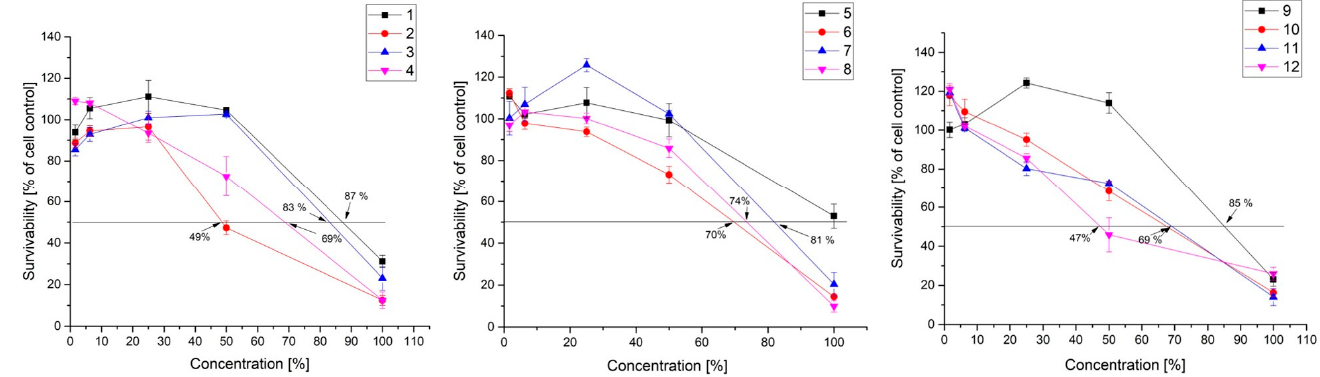
Figure 1. The cytotoxicity of samples of CFSs from the studied LAB strains 1. KC 5-12, 2. KC 5-13, 3. KC 5-14, 4. KZC 8-21-1, 5. KZC 8-23-5, 6. C 10-31-3, 7. KO 4-4, 8. KO 3-7-5, 9. KZM 2-11-3, 10. KZM 2-11-1, 11. KZM 2-11-3 (SM), 12. KZM 2-11-1 (SM) on the MDBK cell line. Dose-response curves were generated based on the cytotoxicity data and the CC 50 concentration was calculated for 11 from 12 CFSs. Only KZC 8-23-5 even in 100% concentration did not achieve 50% cytotoxicity (47%). The CC 50 value is between 47% and 85% for all other CFSs.